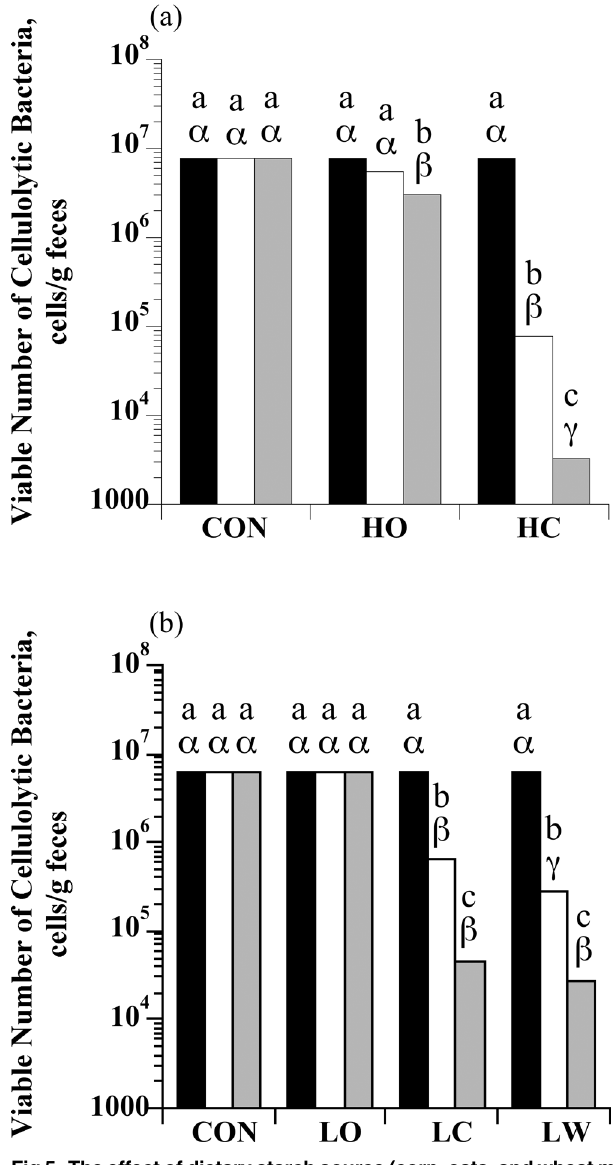
Fig 5. The effect of dietary starch source (corn, oats, and wheat middlings) on the viable number of total cellulolytic bacteria in equine feces. (a) Horses were assigned to treatments: hay only (CON; n = 4), high oats (HO; n = 4; 2 g starch/kg BW), or high corn (HC; n = 4; 2 g starch/kg BW). (b) Horses were assigned to treatments: hay only (CON; n = 5), low oats (LO; n = 5; 1 g starch/kg BW), low corn (LC; n = 5; 1 g starch/kg BW), or low wheat middlings (LW; n = 5; 1 g starch/kg BW). An initial sample was obtained at the end of the forage-only feeding period (S0; black bars) before starch sources were introduced. Additional samples were taken on d 6 when horses were receiving 50% of the assigned starch source (S1; open bars) and on d 13 when they were receiving 100% of the assigned starch source (S2; grey bars). Means lacking a common English letter are different within sample day ( P < 0.05). Means lacking a common Greek letter are different between sample days within a treatment ( P < 0.05); (a) Treatment: P < 0.0001, sample day: P < 0.0001, and treatment × sample day: P < 0.0001; Pooled SEM: treatment = 0.1059, sample day = 0.0935, and treatment × sample day = 0.1620 (log 10 transformed); (b) Treatment: P < 0.0001, sample day: P < 0.0001, and treatment × sample day: P < 0.0001; Pooled SEM: treatment = 0.0894, sample day = 0.0614, and treatment × sample day = 0.1227 (log 10 transformed).